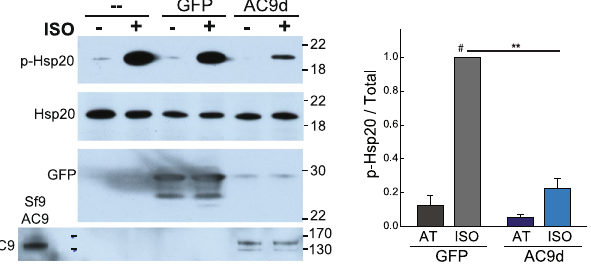
Figure 5. Expression of catalytically inactive AC9 decreases isoproterenol-stimulated phosphorylation of Hsp20 in rat neonatal cardiac myocytes (RNCMs). Cells were infected with GFP control or catalytically inactive AC9-D399A (AC9d) adenoviruses for 50 hr. RNCMs were treated with vehicle (AT) or isoproterenol (1 μ M) for 5 min prior to cell lysis. The ratio of p-Hsp20 to total Hsp20 was quantitated by WB. # , ** P < 0.01 t-test, n = 4. Full-length WBs are presented in Supplementary Fig. S6.